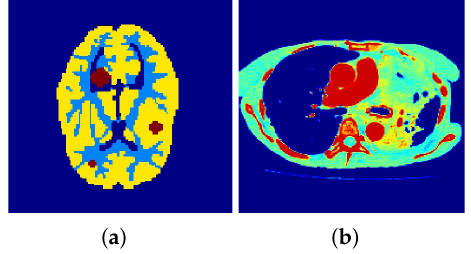
Figure 1. Input images: ( a ) Hoffman Brain Phantom and ( b ) standard medical image of an